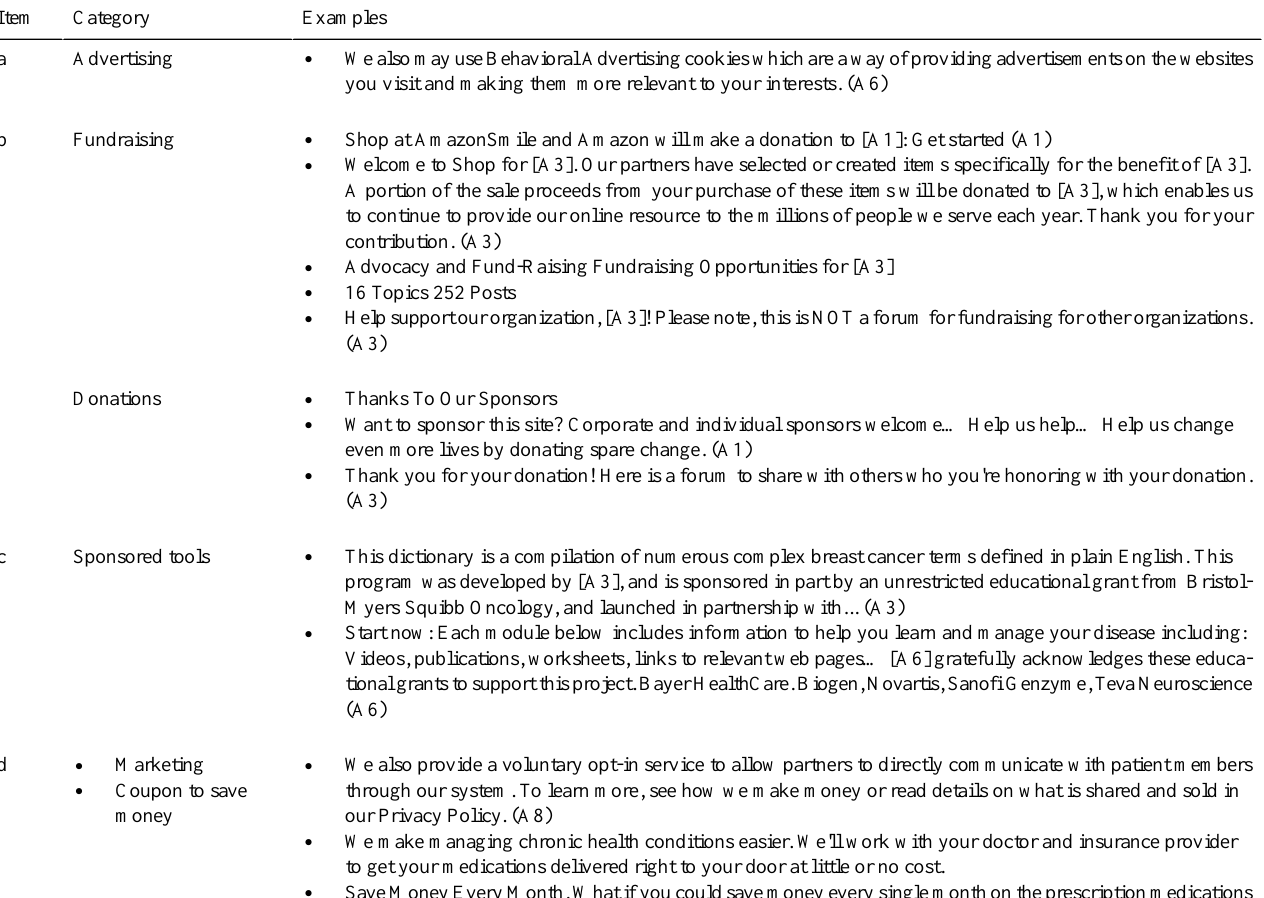
Table 5. Examples of data on income-generating